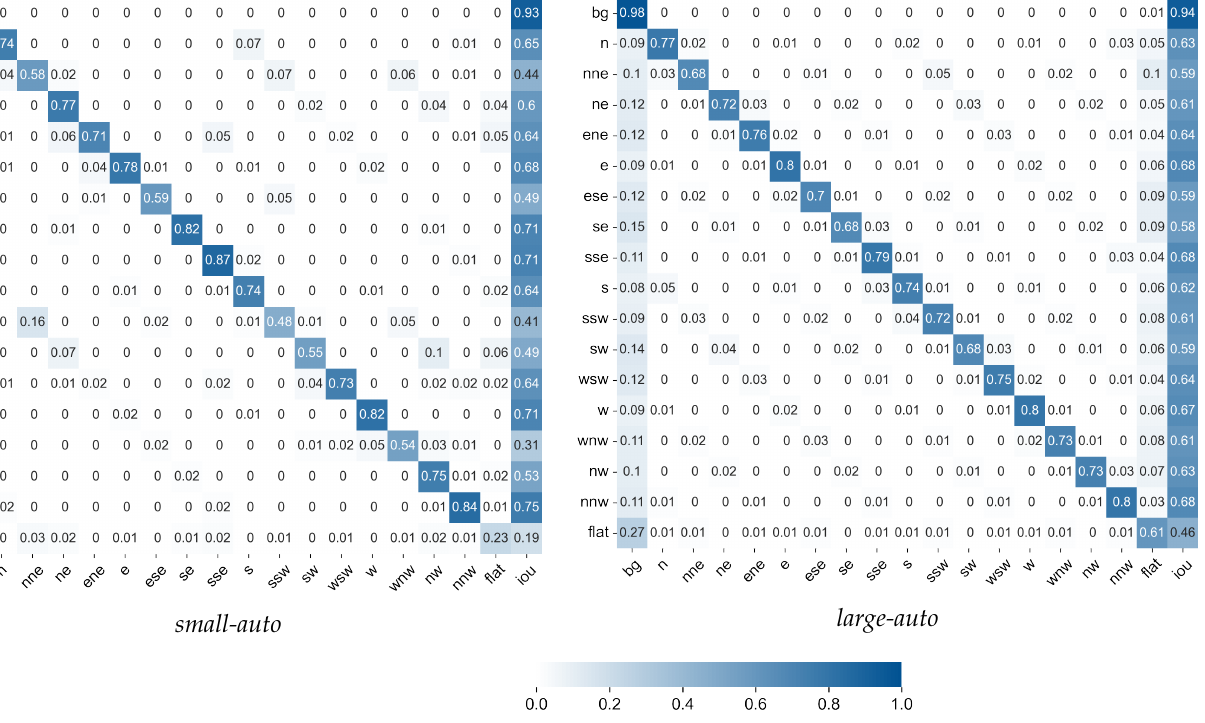
Figure 6. Confusion matrices of the models small-auto and large-auto evaluated on their own test sets. Rows are ground truth, columns are predictions. Rows are normalized to total number of predictions, but do not always sum up to one due to rounding to two digits. Last column shows IoU of each